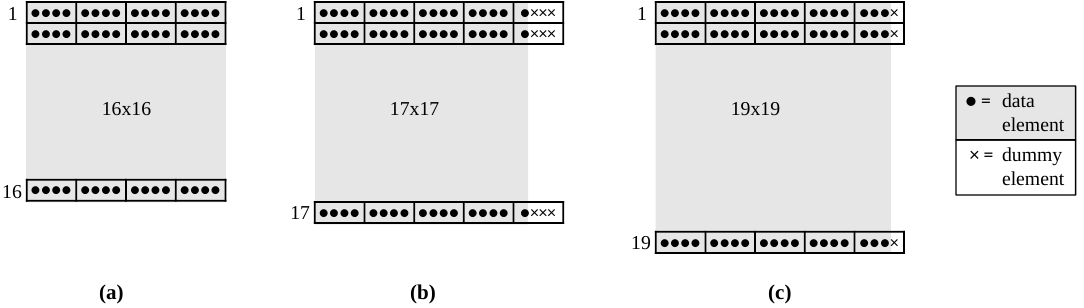
Figure 1. Different memory mappings when applying padding to a N holding L elements: ( a ) r = ( N mod L ) = 0, ( b ) r = 1, ( c ) r =